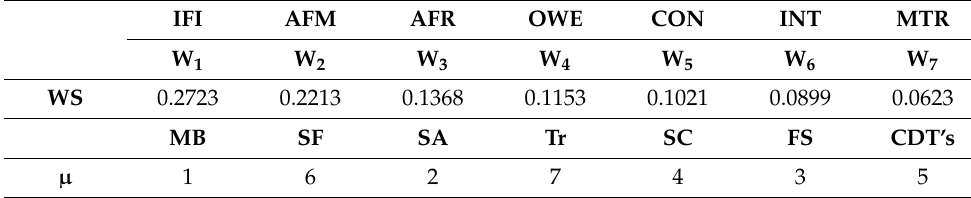
Table 6. Weighting vectors and induced values for